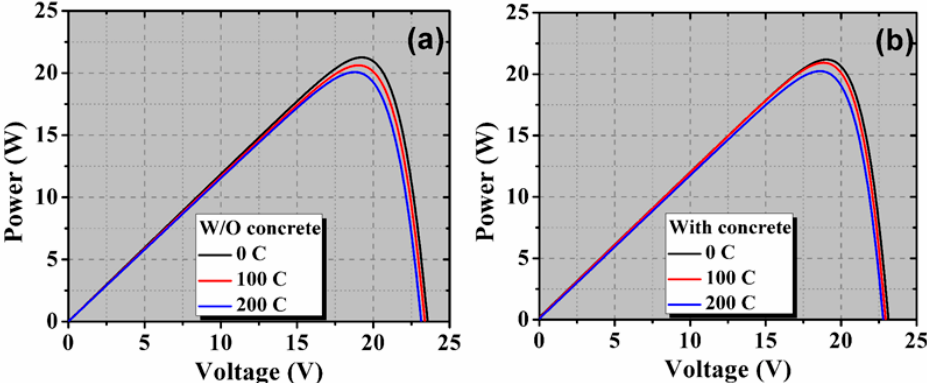
Figure 4. Illuminated I - V curves after thermal cycling of 0, 100, and 200 cycles for PV module ( a ) without concrete and ( b ) with concrete. The inset shows a magnified part to see the difference in the I sc values.